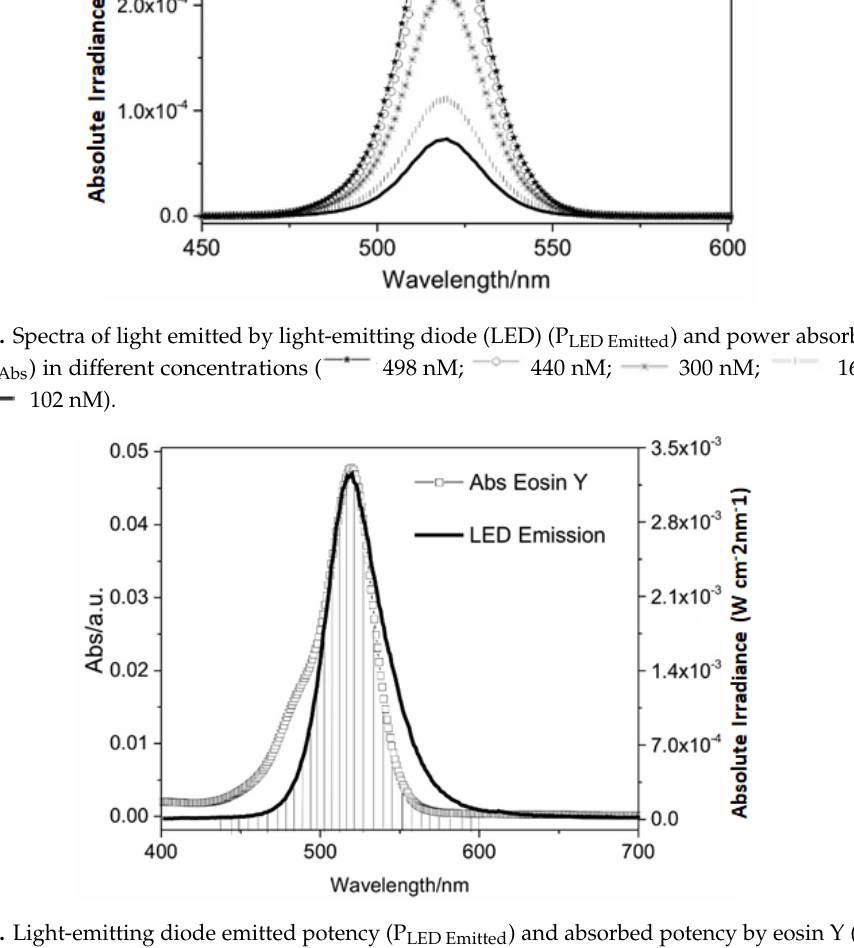
Figure 1. Spectra of light emitted by light-emitting diode (LED) (P LED Emitted ) and power absorbed by eosin (P Abs ) in different concentrations ( 498 nM; 440 nM; 300 nM; 160 nM; and 102